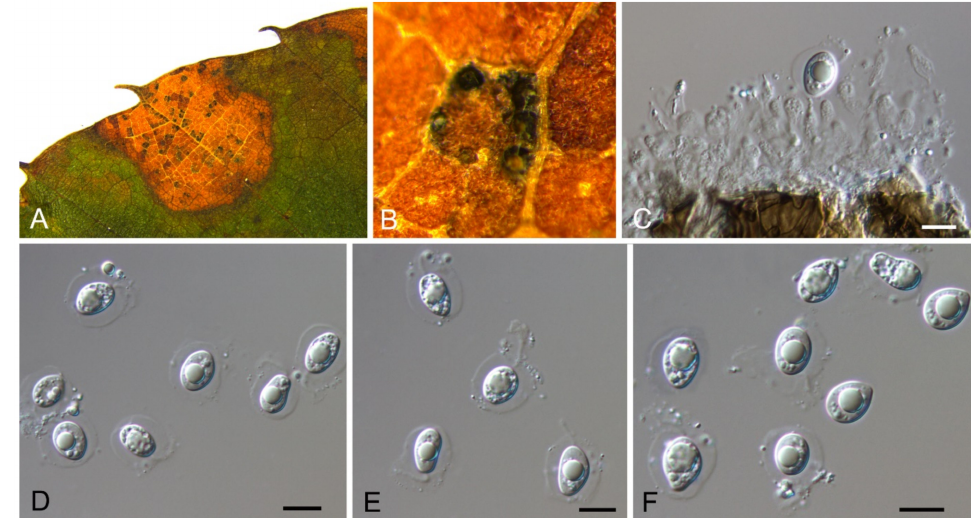
Figure 4. Phyllosticta capitalensis (BJFC-S1820). ( A , B ) Conidiomata on the diseased leaves of Castanea mollissima ; ( C ) Conidiogenous cells giving rise to conidia; ( D – F ) Conidia. Scale bars: ( C – F ) = 10 µ m. 3.4. Aureobasidium Viala & G. Boyer Aureobasidium castaneae C.M. Tian & N. Jiang, sp. nov. (Figure